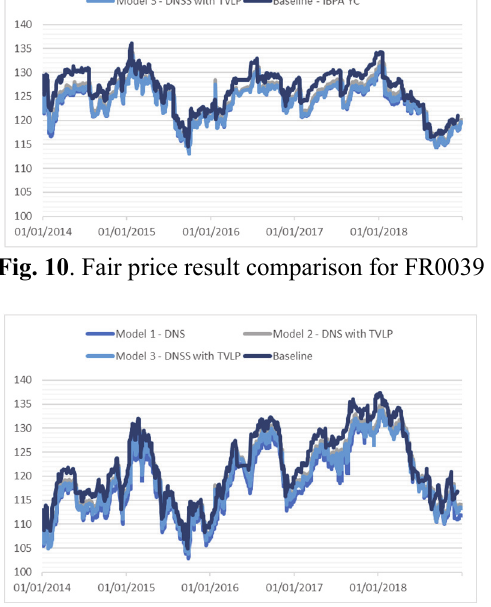
Fig. 12 . Fair price result comparison for FR0045 Fig. 13 . Fair price result comparison for